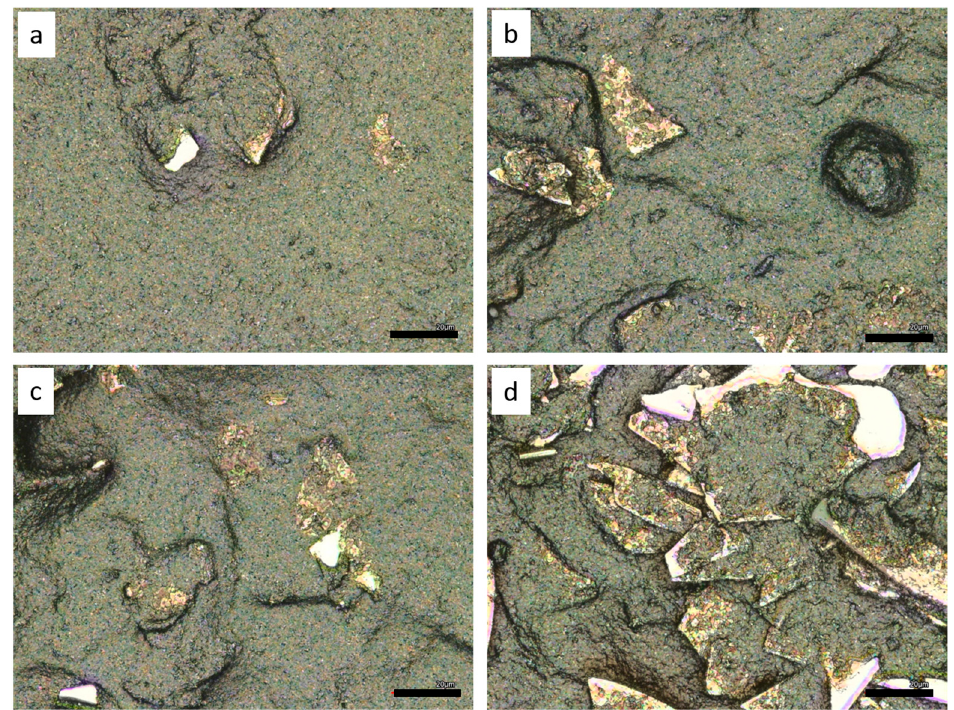
Figure 4. Detailed laser microscopy images of monofilament coated with carbon silicone and Ag352000, ( a ) 5%, ( b ) 25%, ( c ) 30%, ( d ) 40%; size bars 20 µm.